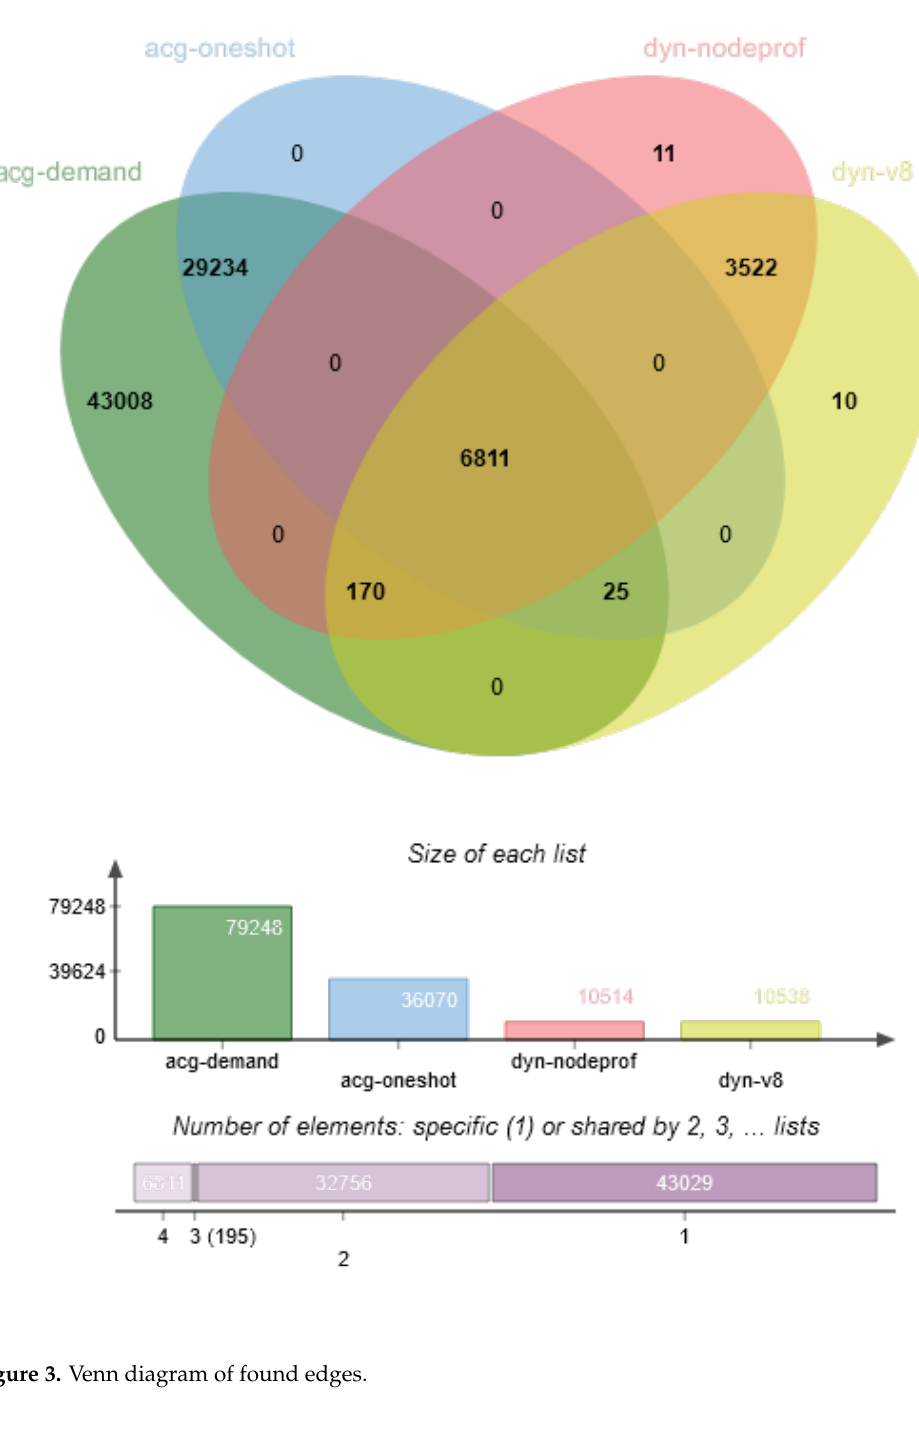
Figure 3. Venn diagram of found